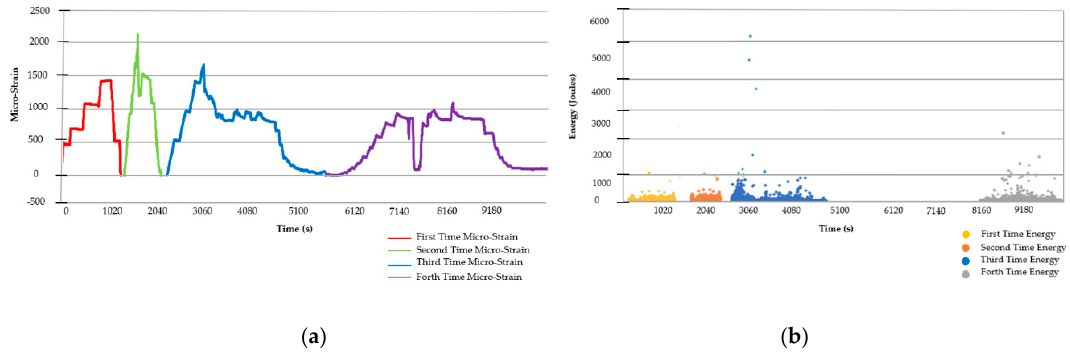
Figure 11. Micro-strain and AE energy over time in compression mode under repeated load test ( a ) micro-strain; ( b ) AE energy.